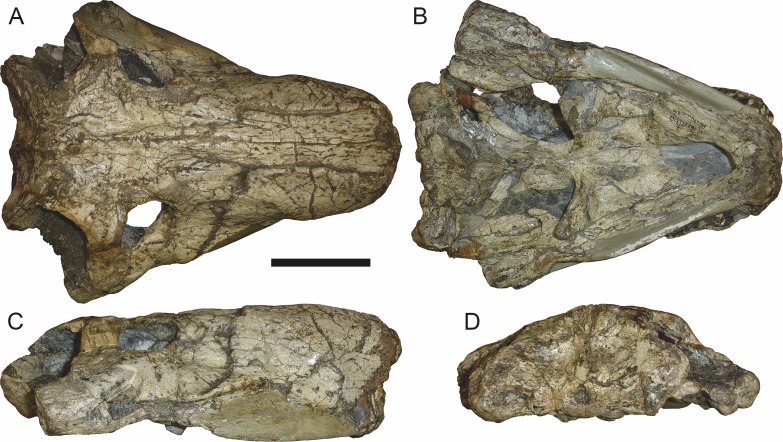
Referred specimen (BP/1/1565) of Sycosaurus laticeps (Haughton, 1924) in (A) dorsal, (B) ventral, (C) right lateral, and (D) occipital view.Scale bar equals 10 cm.